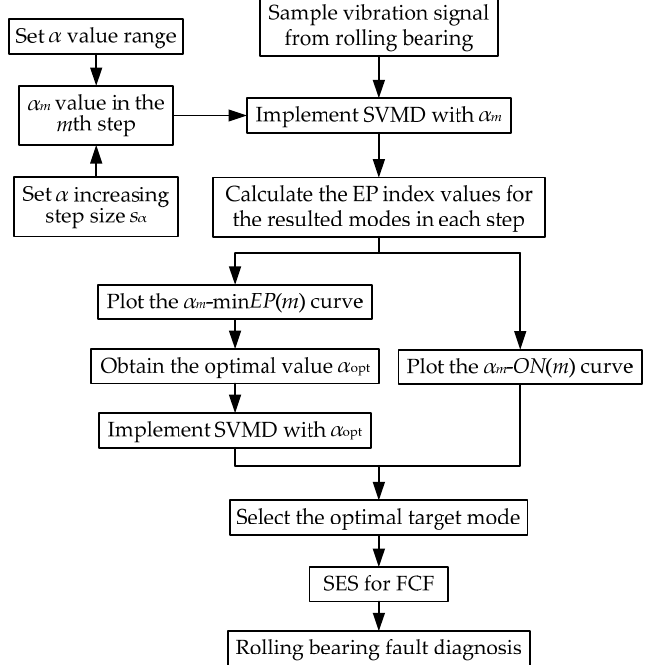
Figure 1. Process flow of rolling bearing fault diagnosis based on SVMD and the EP index.